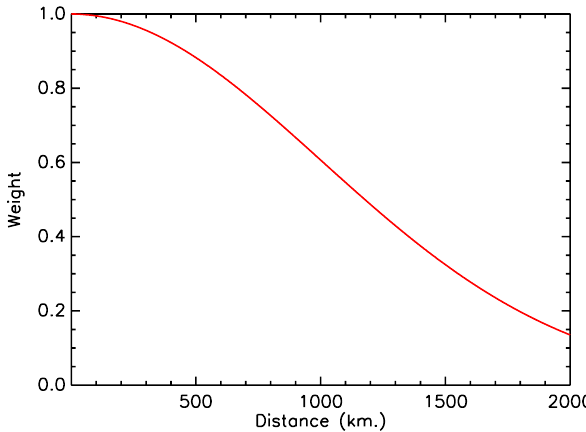
Fig. A4. The Gaussian weight function for proxies located at a distance of x km from a grid node, as derived from Eq. (A3), for an example search radius ( R ) of 2000km.